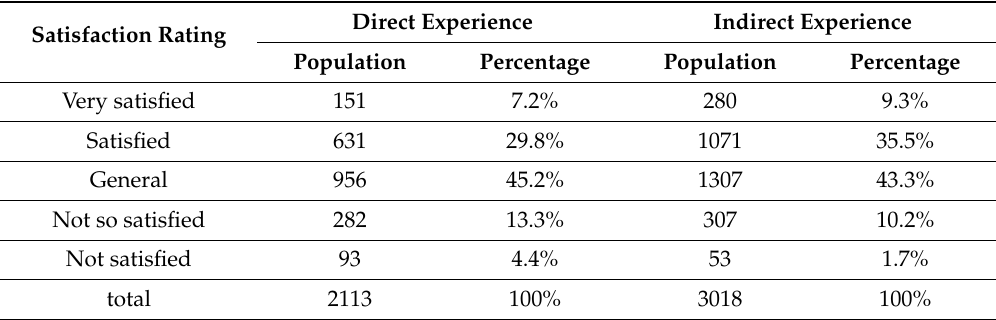
Table 2. A general description of the satisfaction evaluation of government regulation of food safety with or without direct